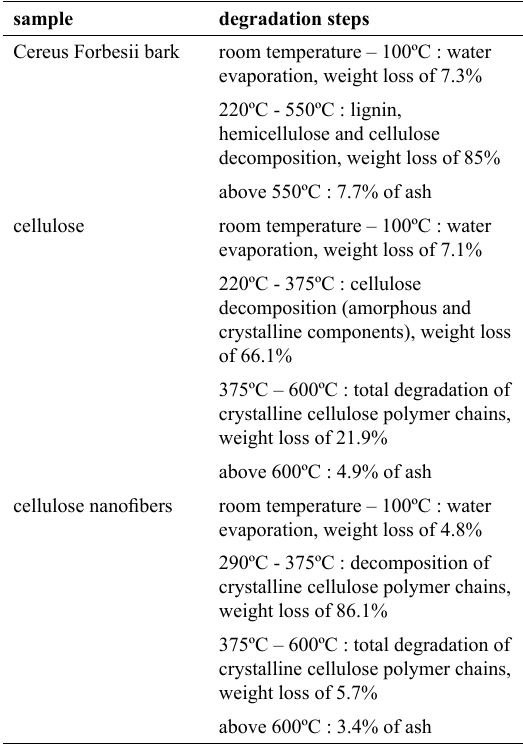
Table 3. Thermal decomposition parameters of the studied samples.